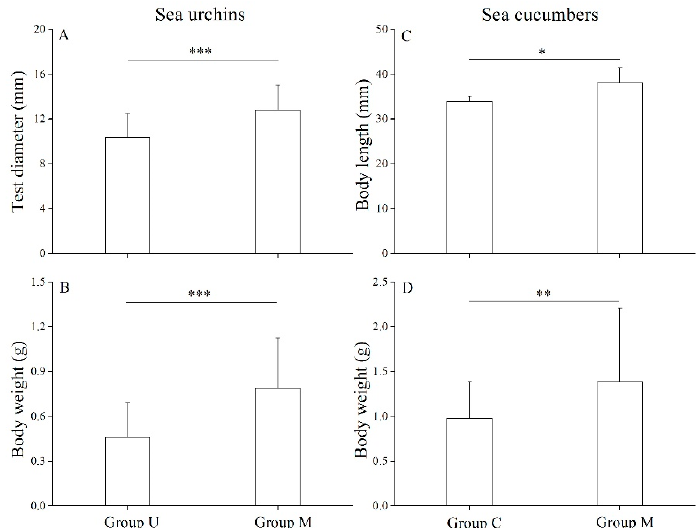
Figure 3. Test diameter ( A ) and wet body weight ( B ) of Strongylocentrotus intermedius between groups U and M. Body length ( C ) and wet body weight ( D ) of Apostichopus japonicus between groups C and M (mean ± SD, n = 6). Group C: the control group for sea cucumbers. Group U: the control group for sea urchins. Group M: the integrated multi-trophic aquaculture of sea cucumbers and sea urchins. The asterisks *, ** and *** mean p < 0.05, p < 0.01, p < 0.001, respectively. No significant difference in lantern length/test diameter was found between groups U (0.033 ± 0.006) and M (0.037 ± 0.005) ( t = 0.002, p = 0.999, Figure 4A)